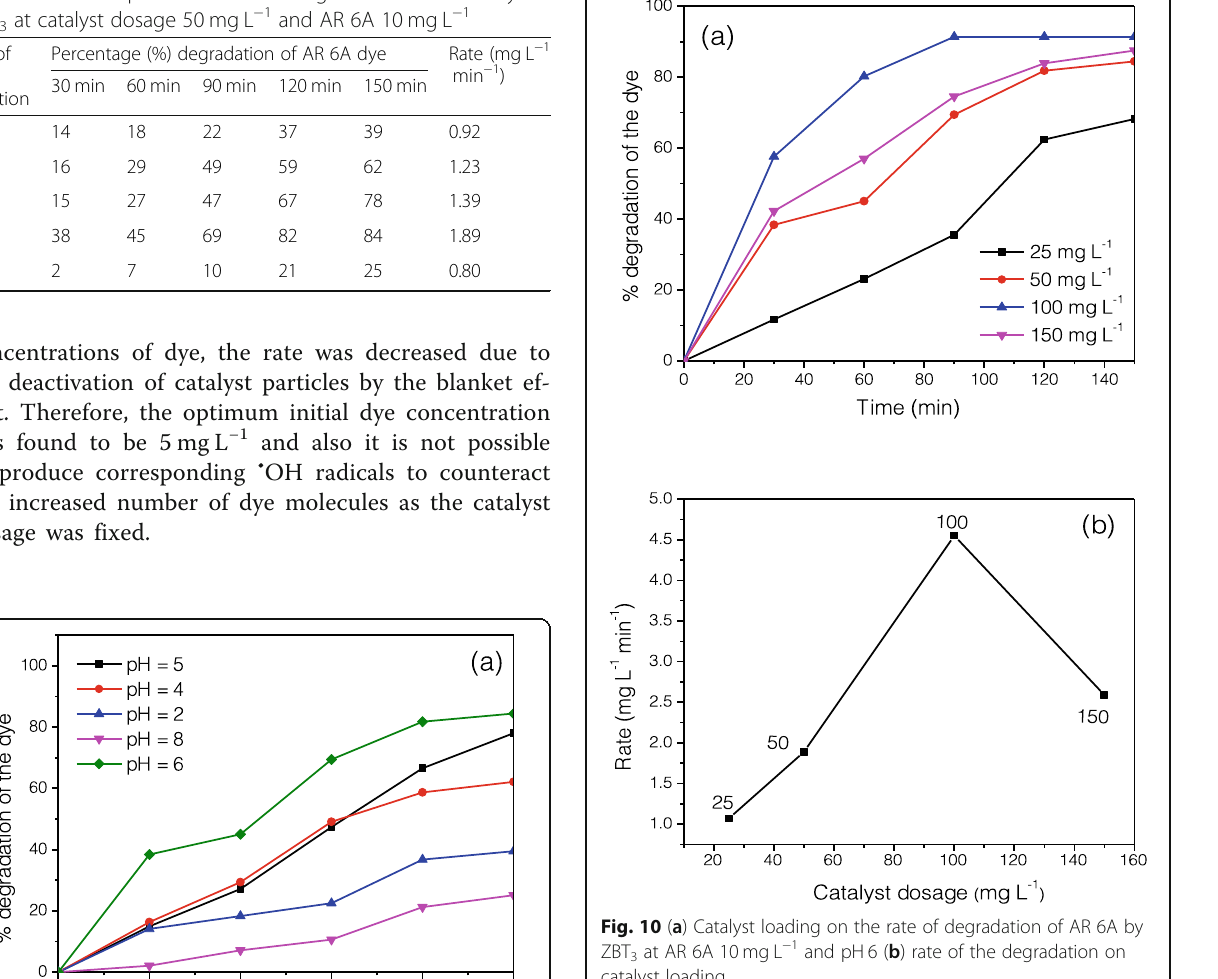
Table 5 Effect of pH on the rate of degradation of AR 6A by